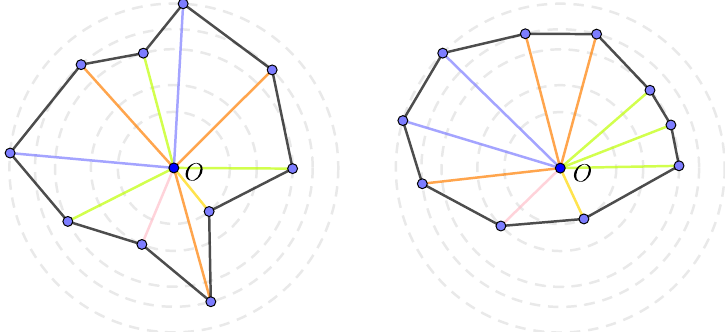
Figure 1. ( Left ) The general configuration of points on the concentric circles that forms a non-convex polygon; ( right ) the convex configuration of points with respect to the constrained vertex